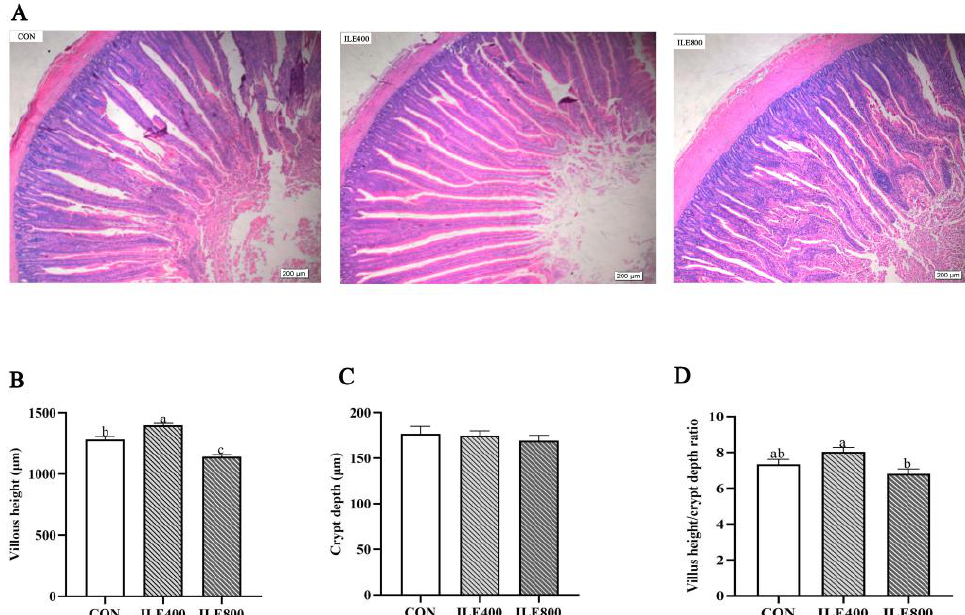
Figure 2. The effect of dietary supplementation with isoleucine (Ile) on duodenal morphology of broilers. ( A ) Hematoxylin and eosin photomicrographs at 40 × magnification; ( B ) Villus height; ( C ) Crypt depth; ( D ) Villus height/ Crypt depth ratio. CON, broiler chickens were fed the basal diet; ILE400, basal diet supplemented with 400 mg/kg Ile; ILE800, basal diet supplemented with 800 mg/kg Ile. The values are presented as the mean and standard error of mean (SEM), and statistically significant differences are those with a,b,c p <